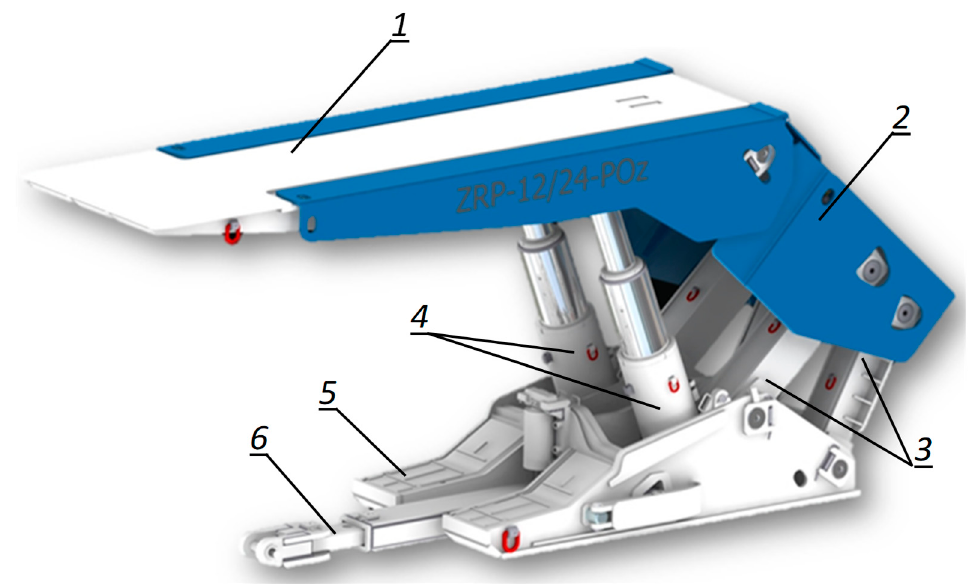
Figure 1. Section of the powered roof support: 1—canopy, 2—shield support, 3—lemniscate tie rods, 4—leg, 5—floor base, 6—shifting system.